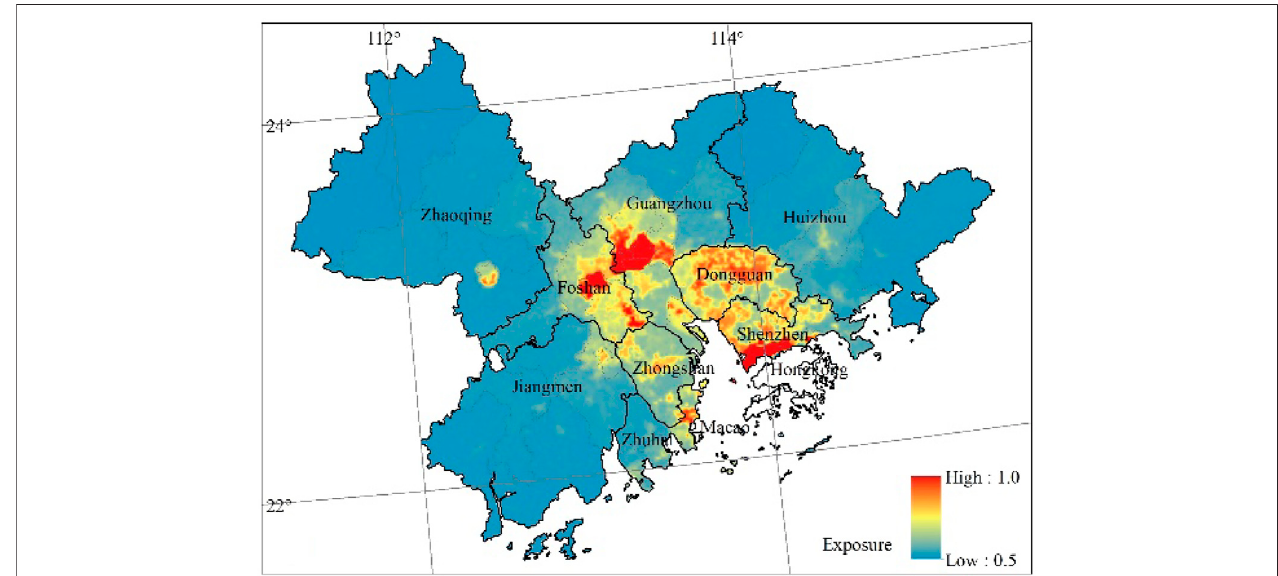
FIGURE 7 | Exposure index distribution of economic society in the GBA in